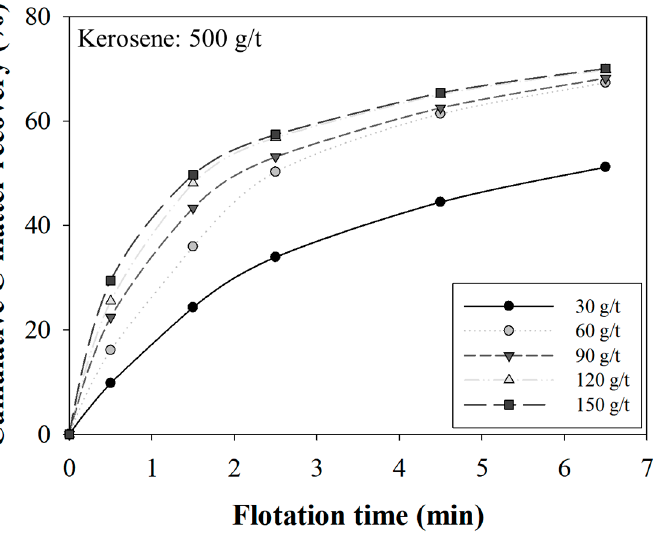
Figure 3. C-matter recovery as a function of MIBC dosage (30 − 150 g/t): kerosene dosage, 500 g/t; agitation speed, 1200 rpm.